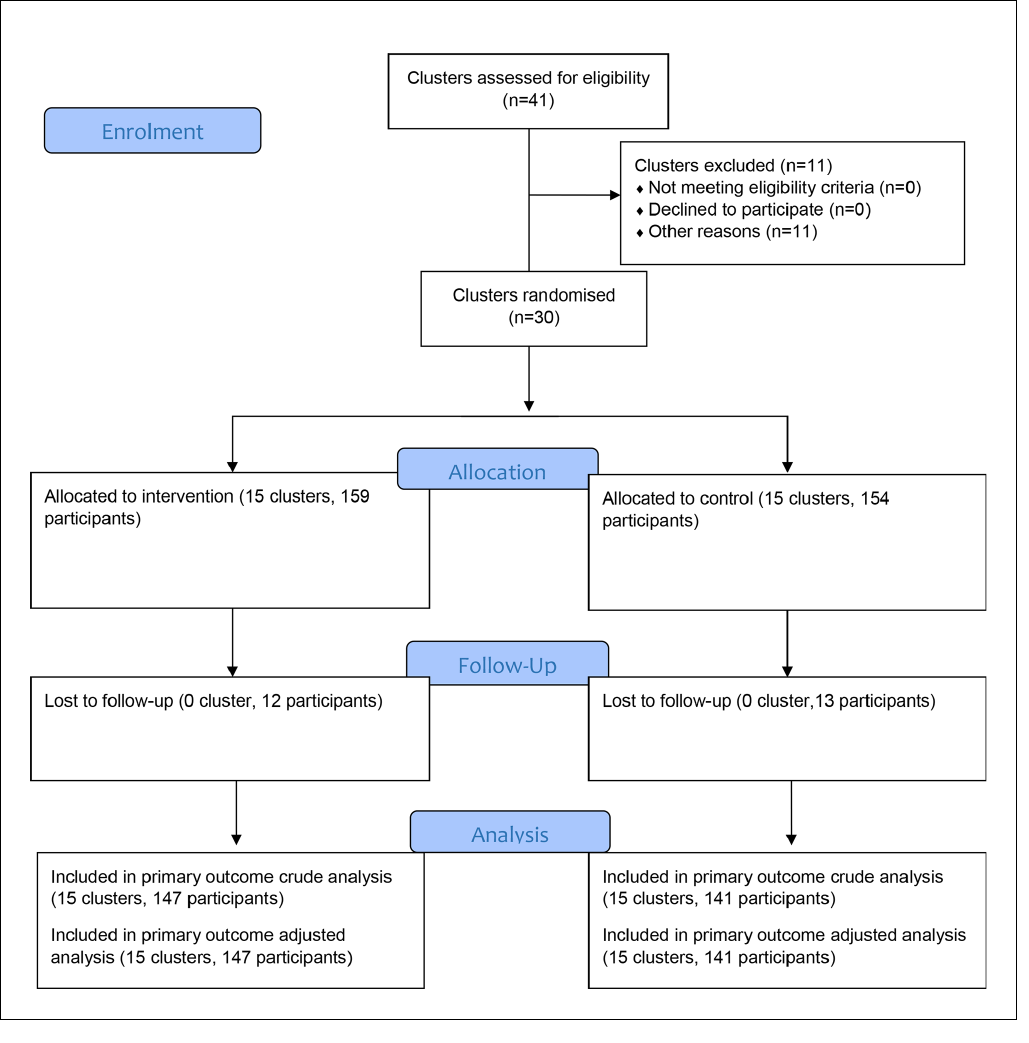
Figure 1. CONSORT trial flow